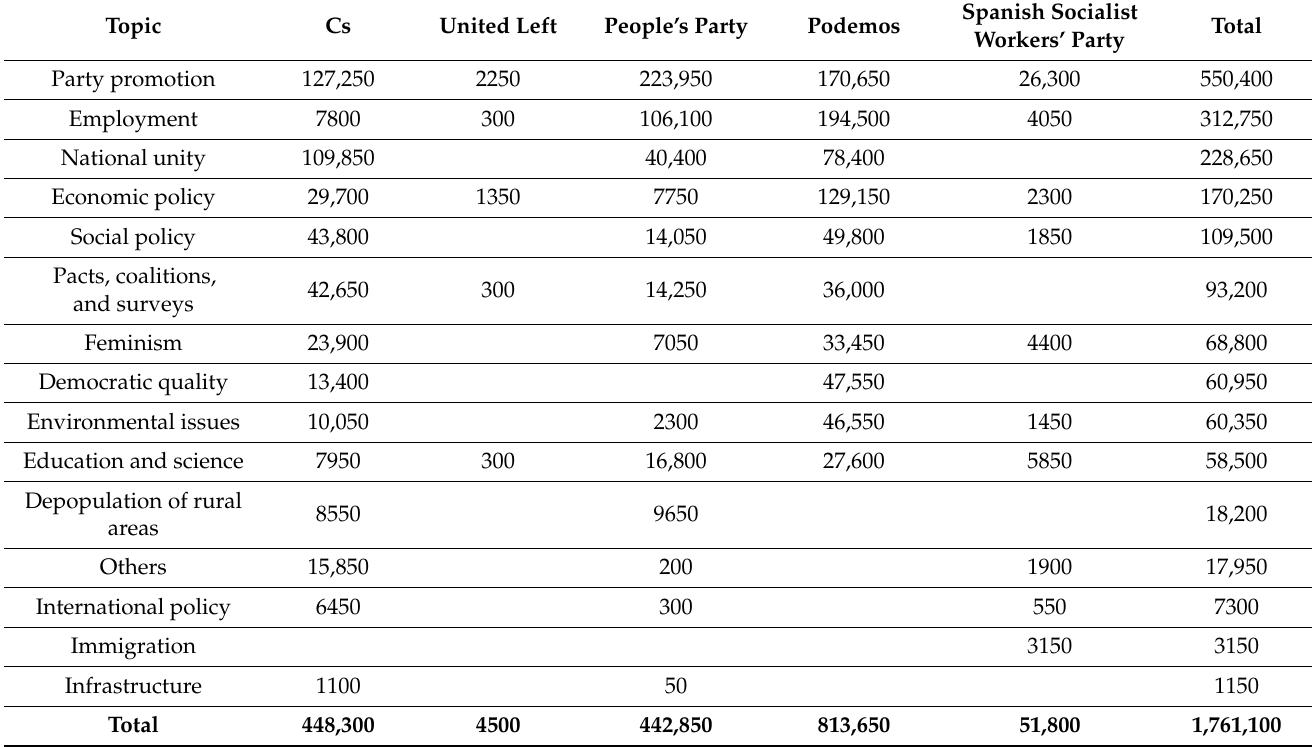
Table 4. Estimated cost by topic of the Facebook ads published by the six Spanish parties in both 2019 election campaigns ( n = 14,695). Source: Own